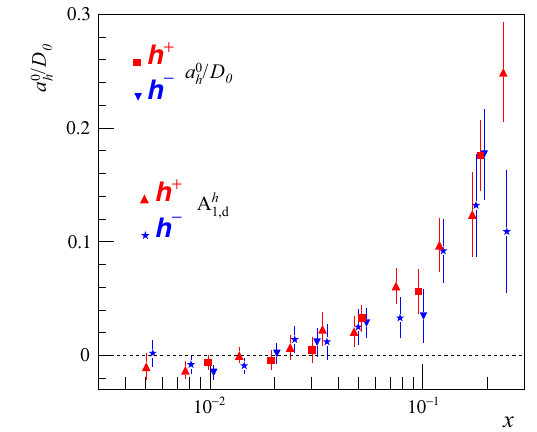
( x )/ D ( x , y ) for 2002– 0 h ± ± ( x ) 1 d